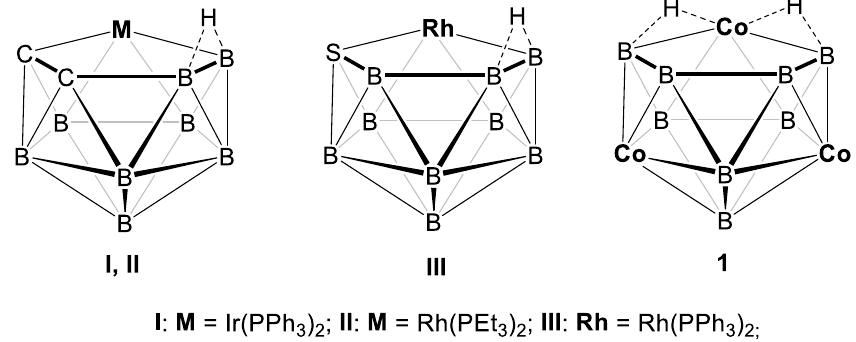
Chart 1. Examples of 11-vertex− 12-SEP ( skeletal electron pairs) nido -metalla(hetero)borane clus- ters.